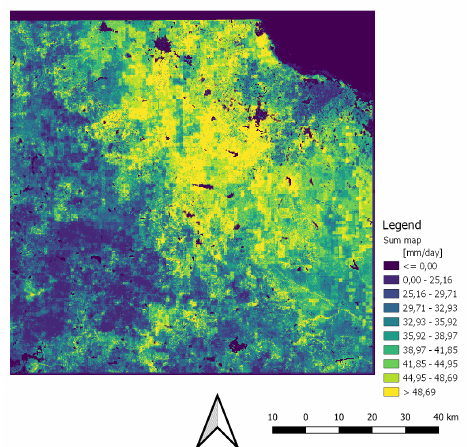
Figure 6. Sum map of the daily evapotranspiration maps in the Apulia area in March 2019.